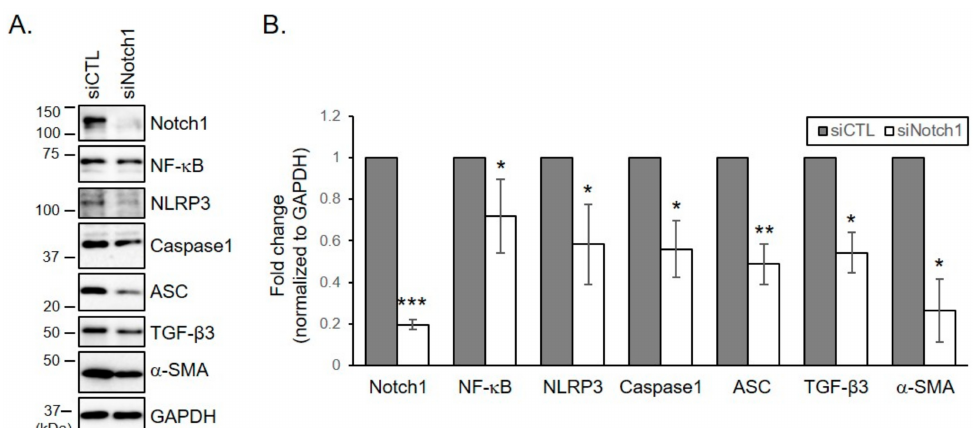
Figure 4. Depletion of Notch1 in keloid fibroblasts reduces increased levels of inflammasome proteins and myofibroblastic marker. Keloid fibroblasts from patients 2, 3, and 6 were transfected with indicated siRNAs (control and Notch1). After four days, cells were lysed and subjected to immunoblotting with indicated antibodies. ( A ) Gels are representative of five experiments using keloid 3. ( B ) Graphs represent means ± s.d. of five independent experiments. * p < 0.05; ** p < 0.01; *** p < 0.001. 2.6. Treatment of Keloid Fibroblasts with Rapamycin Reduces Increased Levels of Inflammasomes and TGF- β 3 Proteins